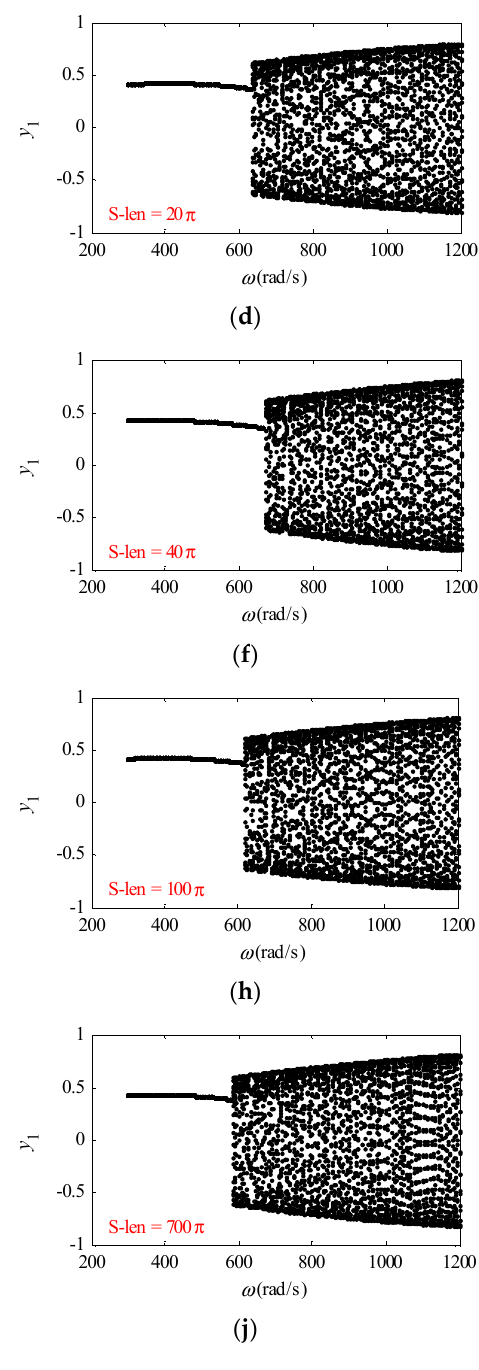
Figure 11. Bifurcation diagrams of POM of 2-DOFs for the initial displacement and velocity x i = y i = y 8 = 0.1, . = 0 ( i = 1 . . . 7 ) at different sampling lengths at ω = 500 rad/s: ( a ) S-len = 2 π , ( b ) S-len = 5 π , ( c ) S-len = 10 π , ( d ) S-len = y 8 20 π , ( e ) S-len = 30 π , ( f ) S-len = 40 π , ( g ) S-len = 60 π , ( h ) S-len = 100 π , ( i ) S-len = 300 π , ( j ) S-len = 700 π